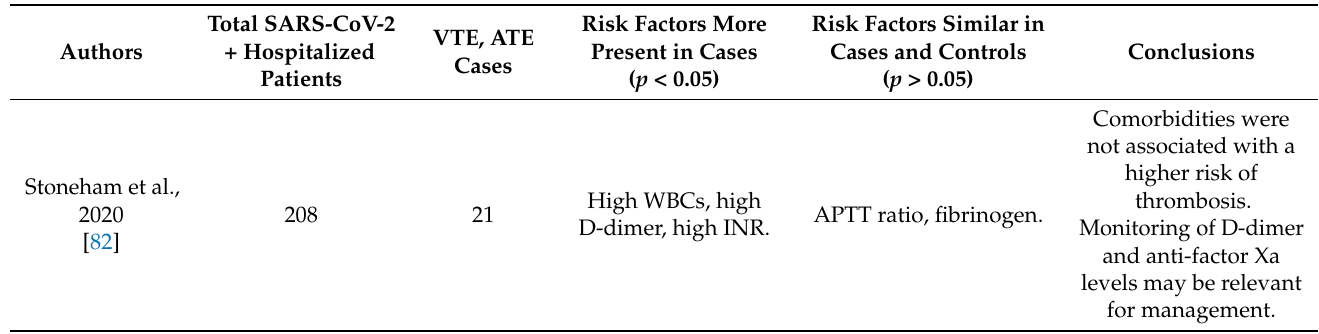
Table 2. The 2020 case-control retrospective studies comparing risk factors for thrombosis develop- ment in hospitalized patients with severe COVID-19 (controls) versus hospitalized patients with both severe infection and DVT or ATE (cases). VTE: venous thromboembolism, ATE: arterial thromboem- bolism, WBCs: white blood cells, INR: international from Nappi et al. [81], Metabolites, 25 May